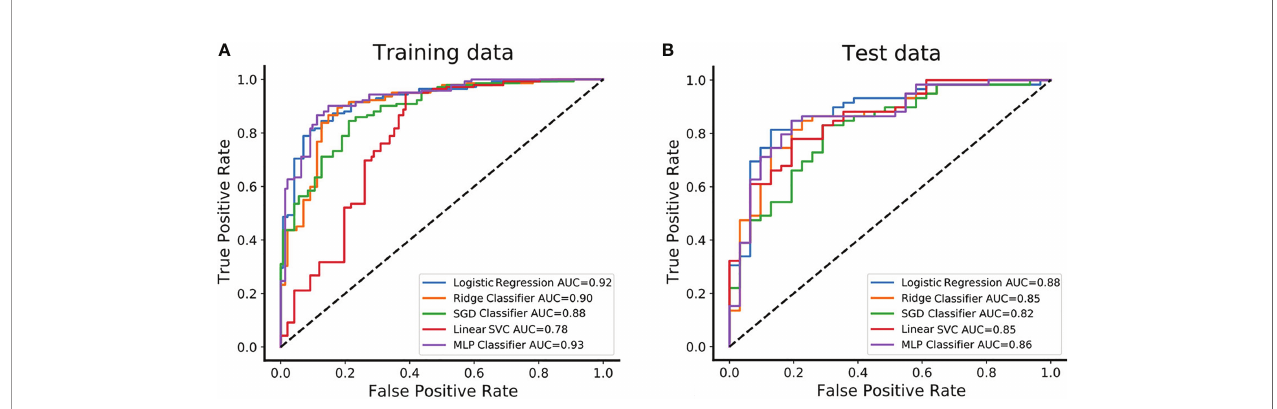
FIGURE 3 | The predictive performance of distinguishing between CS-PAs and CPs in different classi fi ers. (A) The receiver operating characteristic curve (ROC) and the area under the curve (AUC) of the fi ve different classi fi ers are showed in the training set, respectively. (B) The ROC and AUC of the fi ve different classi fi ers are showed in the test set, respectively. SGD Classi fi er, stochastic gradient descent classi fi er; Linear SVC, linear support vector classi fi cation; MLP Classi fi er, multilayers perceptron classi fi